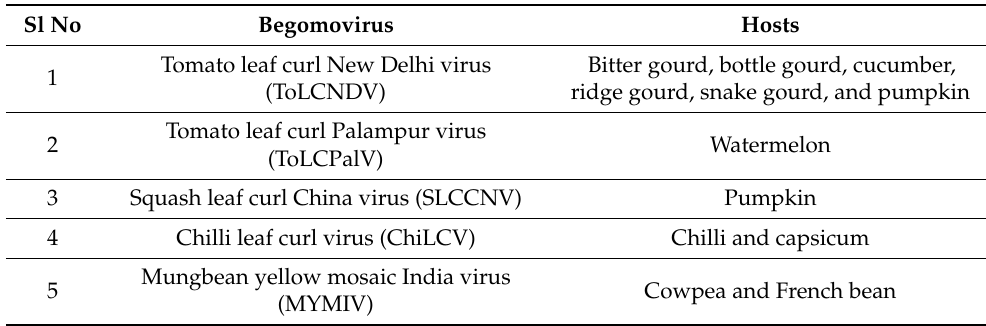
Table 1. Begomoviruses associated with different hosts were used for broad spectrum detection assays. Sl